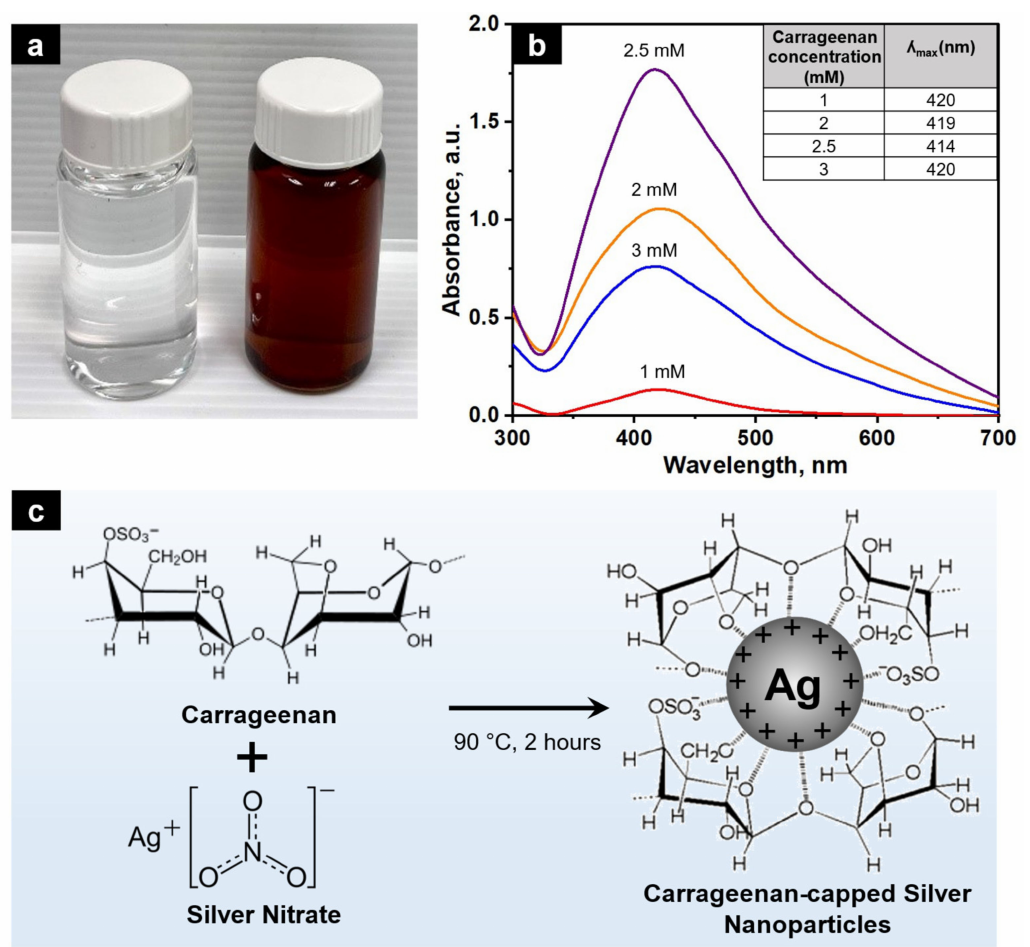
Figure 1. ( a ) Colour of the AgNO 3 and carrageenan mixture before (left) and after (right) reaction at 90 ◦ C for 2 h; ( b ) UV-Vis spectrum of AgNPs produced with different carrageenan concentrations and the corresponding L max ; ( c ) proposed mechanism of the green synthesis of AgNPs by carrageenan as a reducing and stabilising